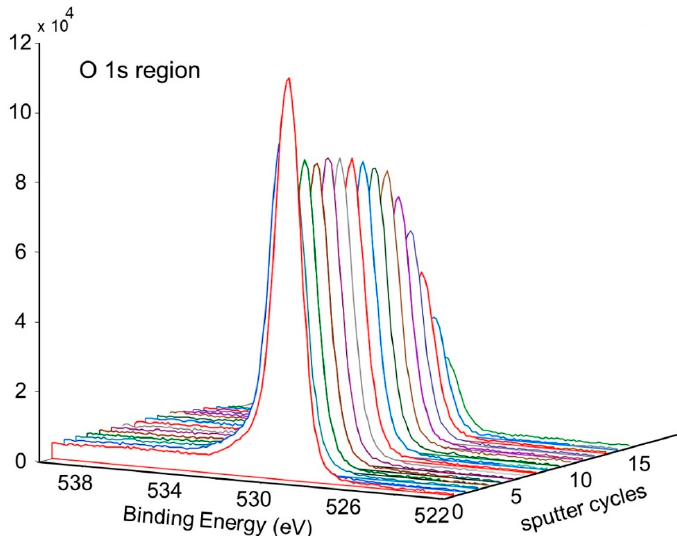
Figure 12. Depth profile for pretreated and activated d-sample showing decrease of NiO and increase of metallic Ni with